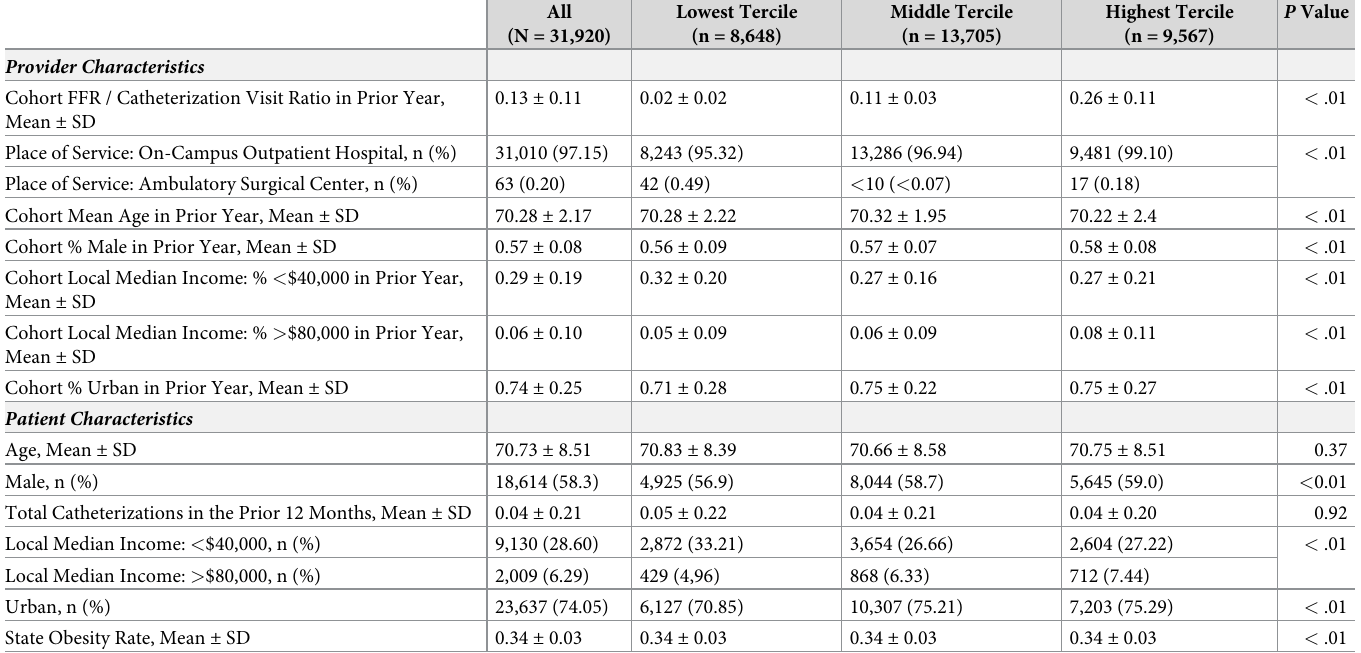
Table 1. Descriptive statistics by provider’s FFR / catheterization ratio